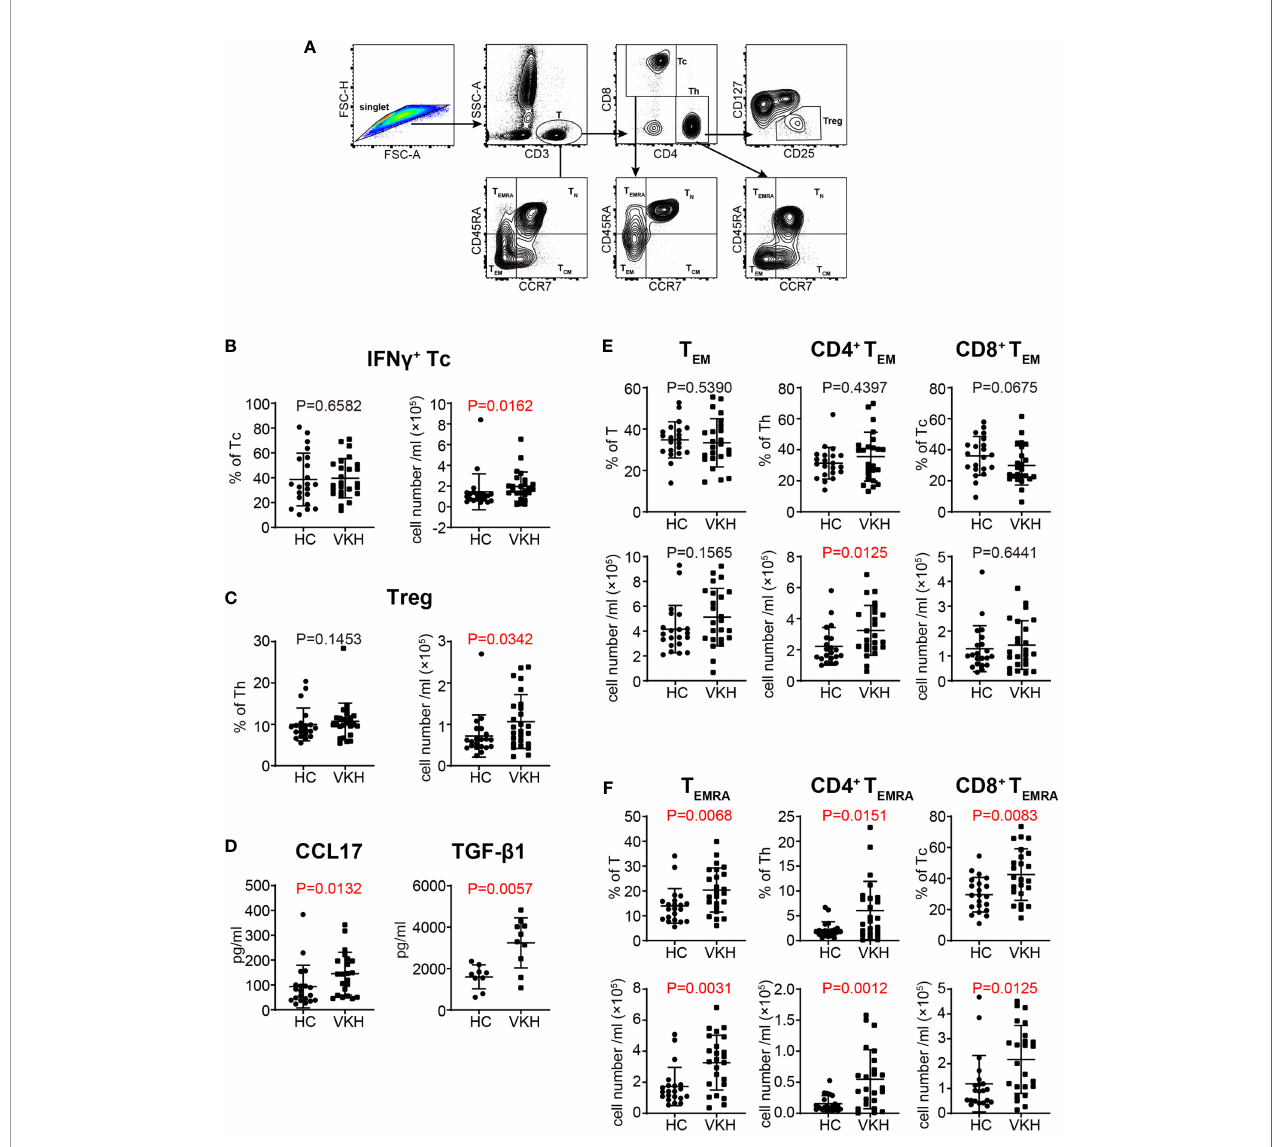
FIGURE 3 | Comparison of T cell subsets de fi ned by cytokine pro fi le and differential status between VKH patients and healthy controls. (A) Gating strategy used for T cell classi fi cation. (B) The absolute number and proportion of IFN- g + CD8 + T cell. (C) The absolute number and proportion of Treg. (D) plasma levels of CCL17 and TGF- b 1 (pg/ml) of HCs and VKH patients. (E) The absolute number and proportion of T EM in total T cells, CD4 + T and CD8 + T cells in HCs and VKH patients. (F) The absolute number and proportion of T EMRA in total T cells, CD4 + T and CD8 + T in HCs and VKH patients. Statistical analysis was performed using Mann – Whitney test. Treg, regulatory T cells; T N , naïve T cells; T CM , central memory T cells; T EM , effector memory T cells; T EMRA , CD45RA + effector memory T